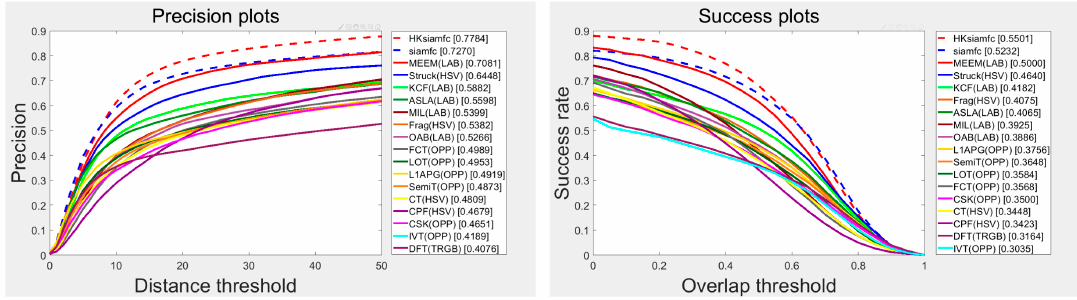
Figure 10. Tracking result of 18 compared trackers on Temple Color (TC128). This picture is best viewed on high-resolution displays.